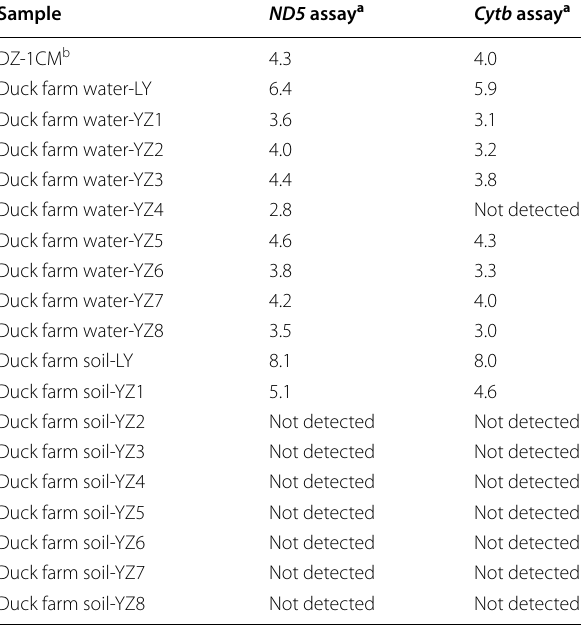
Table 3 qPCR assays conducted on field samples, includ- ing soils amended with chicken manure